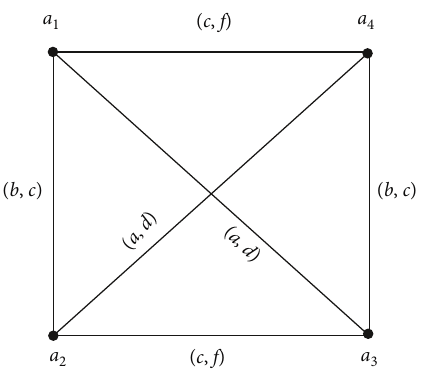
, d ) -regular vague graph with G ∗ 3-RG or 2-RG 1 2